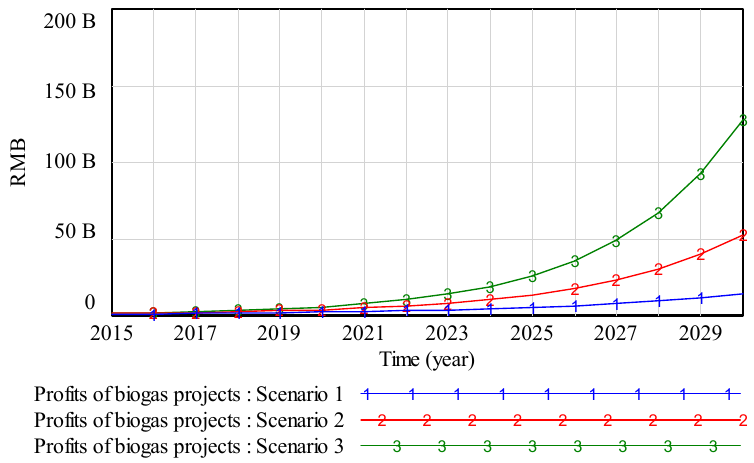
Figure 3. The profits of biogas projects 1 (USD = 6.7722 CNY). Figure 3. The pro fi ts of biogas projects 1 (USD = 6.7722 CNY).